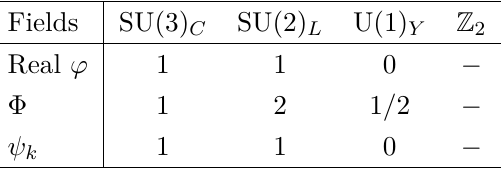
Table 1 . Particle content of the ScotoSinglet Model (ScSM). Here k = 1 , . . . , N are the number